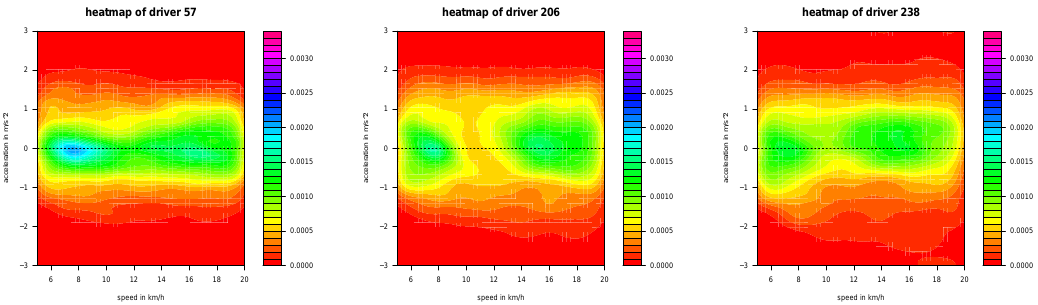
Figure 14. v - a heatmaps x i of the three selected drivers i = 57,206,238.